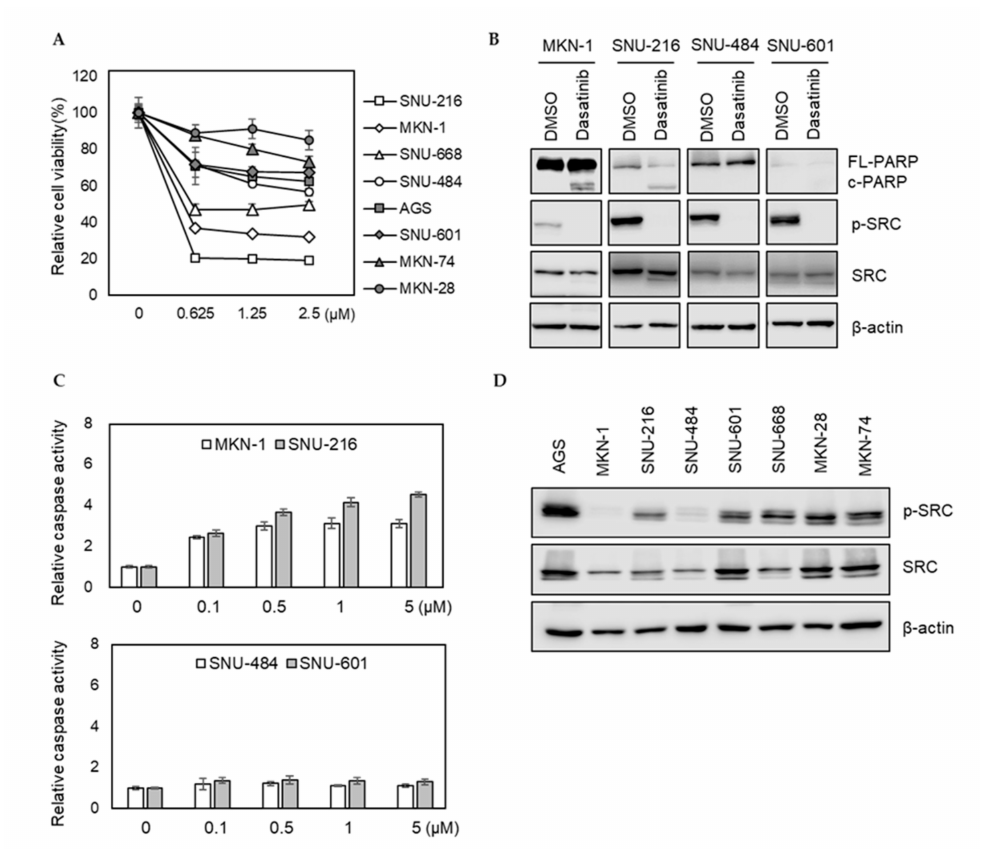
Figure 1. Phenotypic e ff ects of dasatinib in gastric cancer (GC) cell lines. ( A ) Relative cell viability after dasatinib treatment in GC cells. Cells were treated with di ff erent doses of dasatinib (0 to 2.5 µ M) for 72 h, and the cell viability was assessed by MTT assay. Error bars represent standard deviation from representative triplicate experiments from at least three experiments that showed similar results. ( B ) Cells were treated with 500 nM of dasatinib for 48 h, and PARP cleavage and SRC levels were analyzed by Western blot. FL-PARP: full length PARP; c-PARP: cleaved PARP; p-SRC: phospho-SRC (Y416). ( C ) Cells were treated with di ff erent doses of dasatinib (0 to 5 µ M) for 24 h, then caspase activity was analyzed using a Caspase Glo 3 / 7 assay kit. Relative caspase activities are shown. Error bars represent standard deviation from representative triplicate experiments from at least three experiments that showed similar results. ( D ) Basal phospho-SRC (Y416) and total SRC levels in gastric cancer cell lines were determined by Western